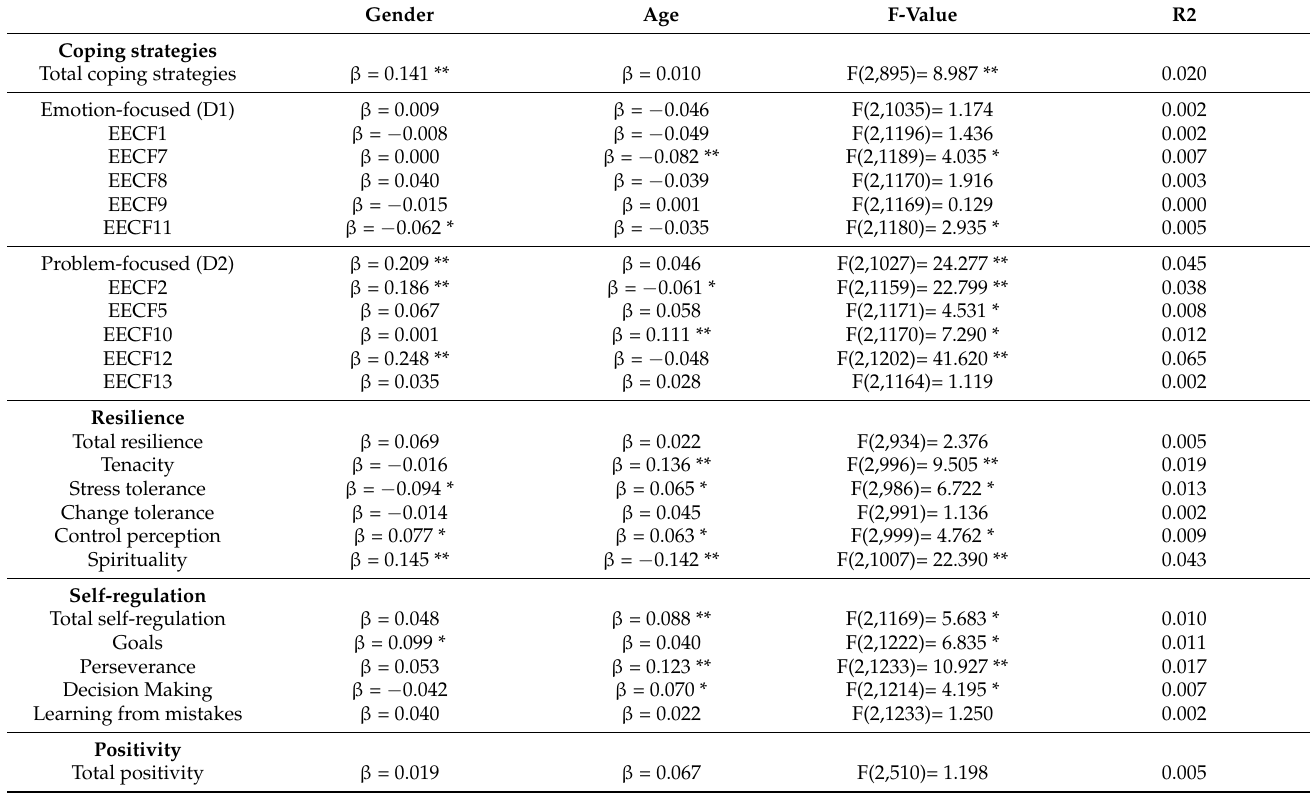
Table 5. Lineal Regression Analysis between Gender and Age, and Well-being Outcomes. Gender Age F-Value